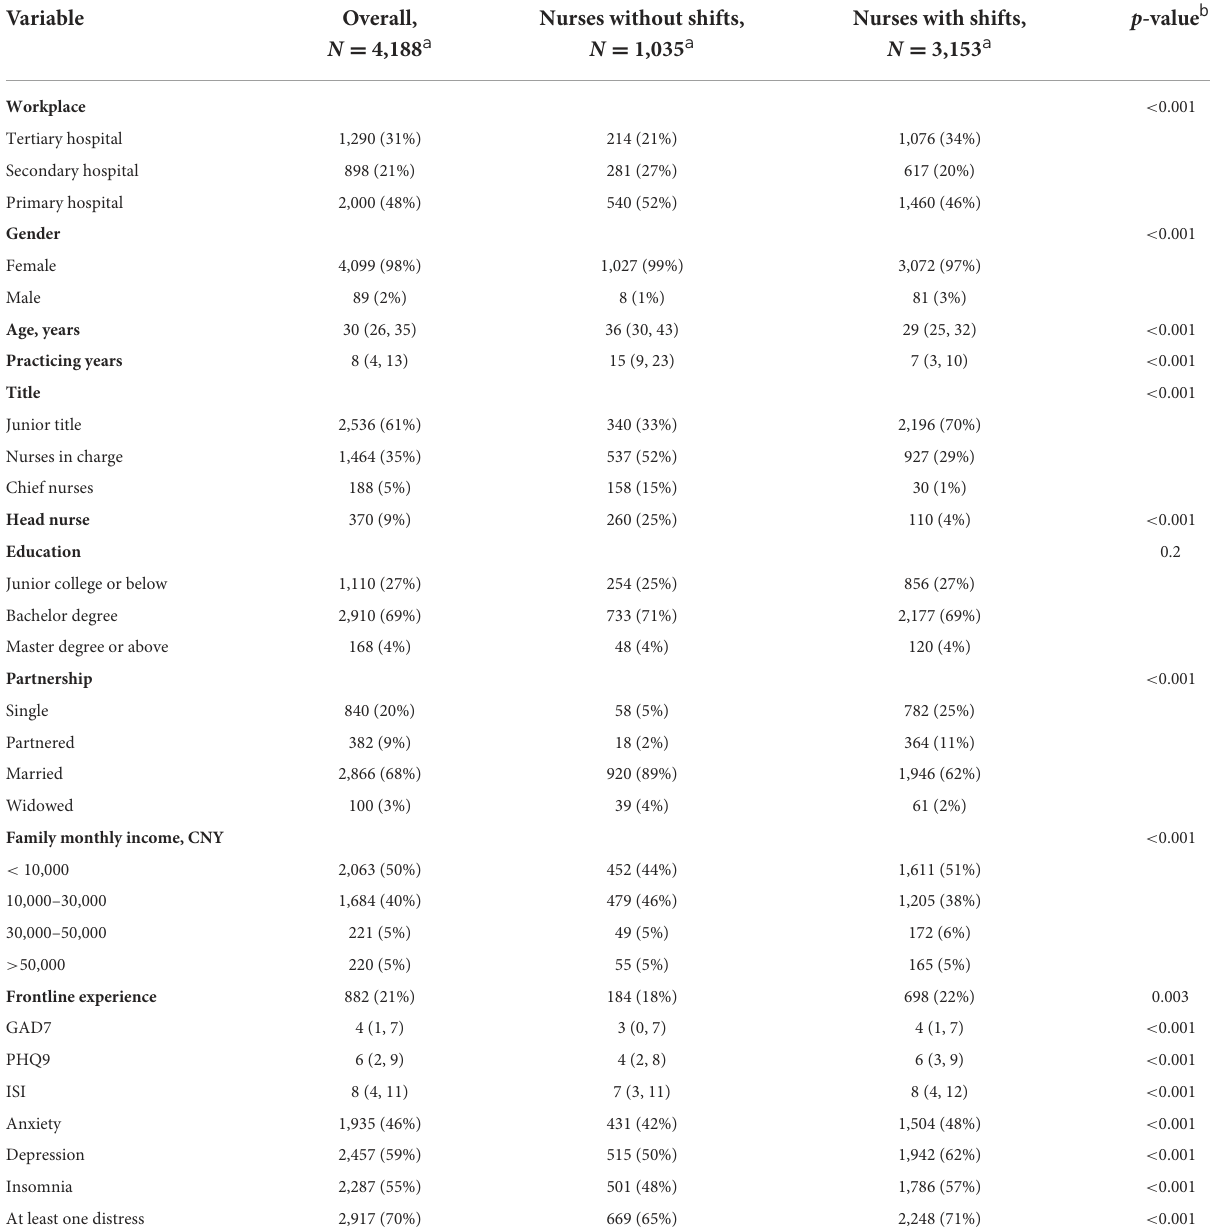
TABLE 1 Characteristics of